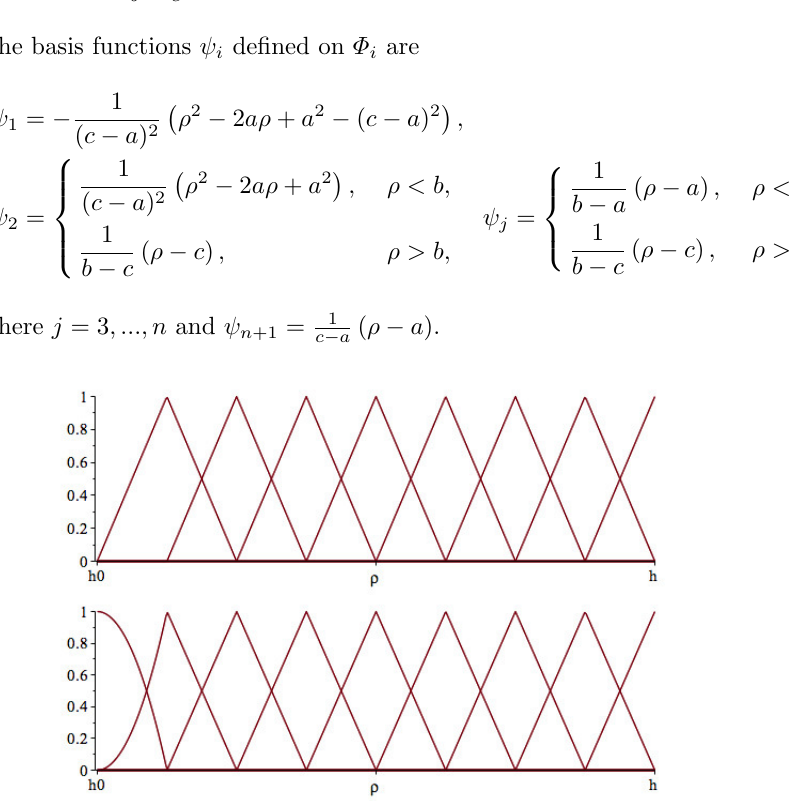
Figure 3. The basis functions φ i and ψ j , defined on [ h 0 , h